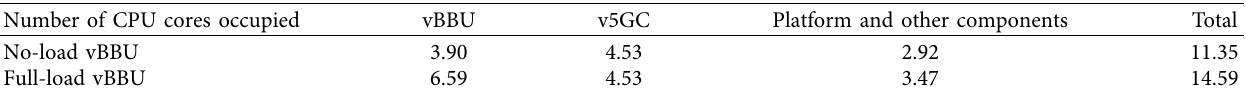
Figure 5: Statistical performance of real-time kernel latency for eight CPU Table 4: Statistics of CPU resource usage.